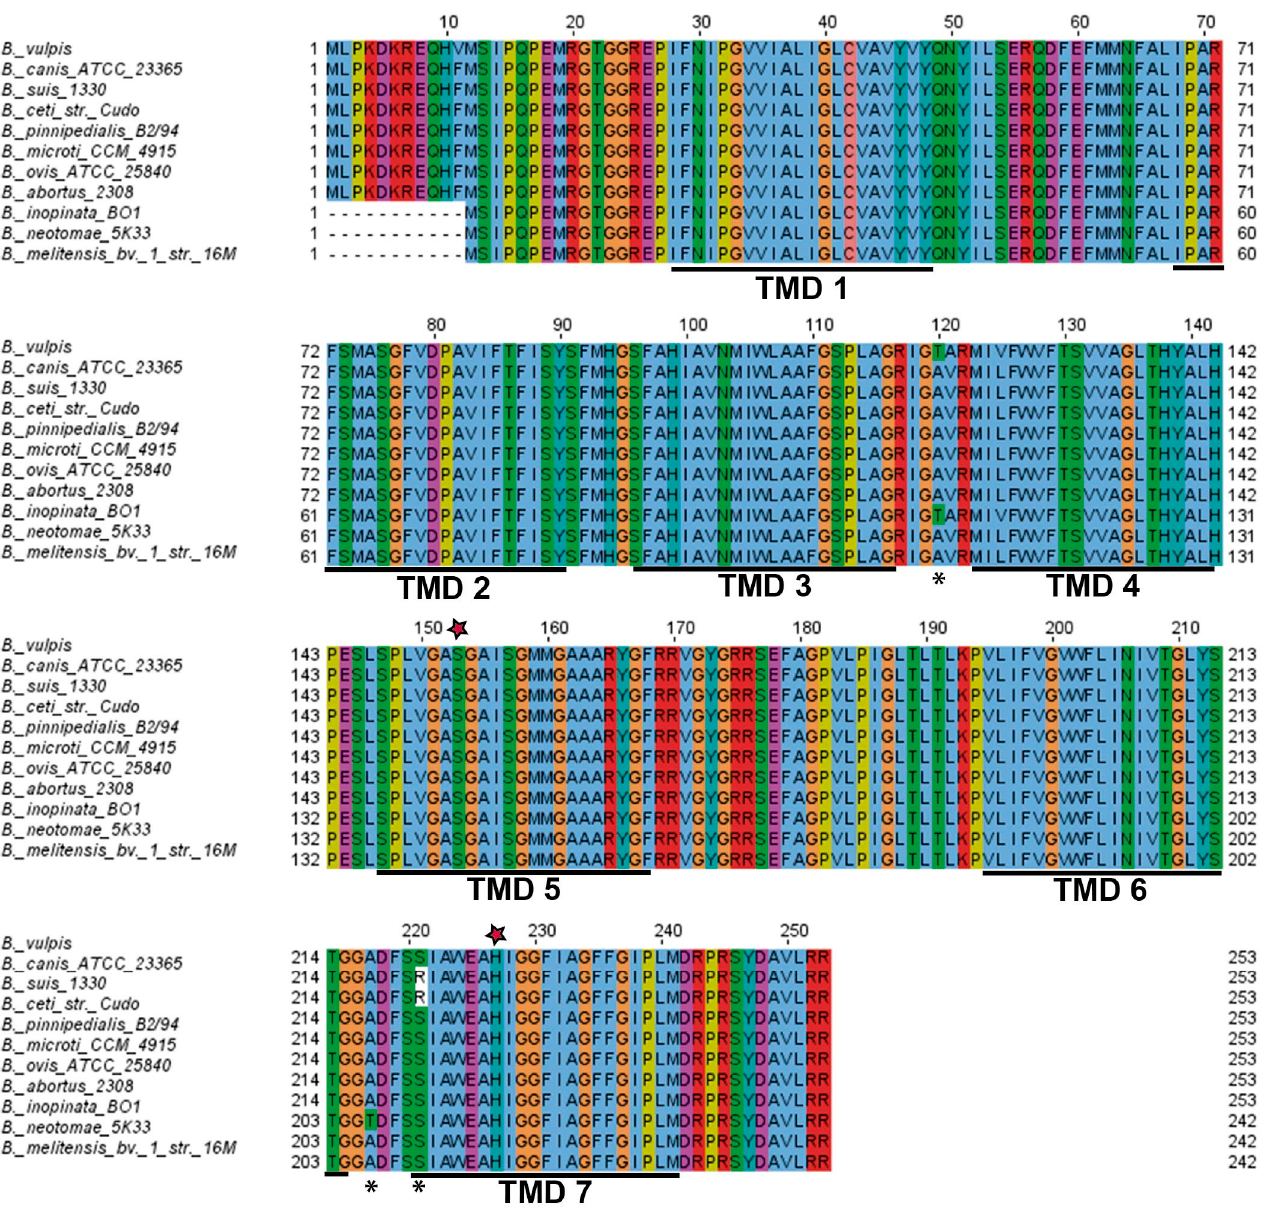
Figure 1. Brucella rhomboid protease. Multiple sequence alignment (Clustal omega) of annotated rhomboid proteases in Brucella species. TMD: transmembrane domain. Asterisks indicate amino acid changes and red stars in Ser(153) and His(227) (in B. abortus ), indicate conservation of catalytic dyad residues in all species in TMD 5 and TMD 7, respectively.